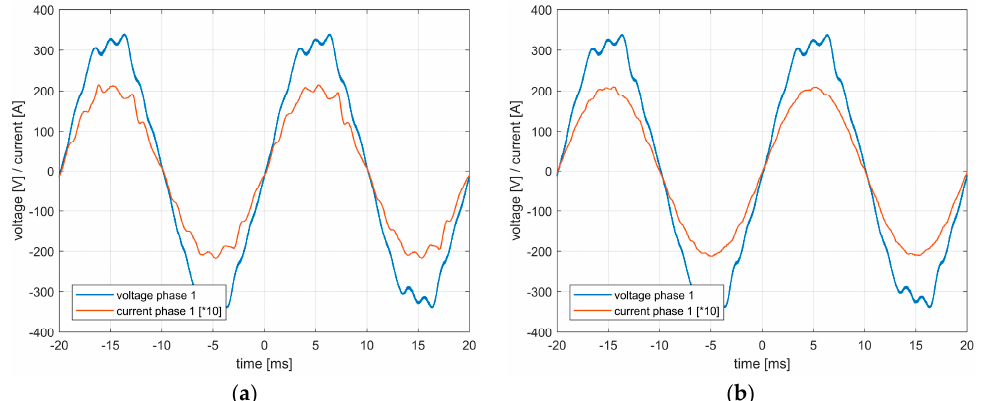
Figure 15. Experimental results with different controller structures and highly distorted grid voltage (Scenario 2): ( a ) PR controller; ( b ) PMR controller.